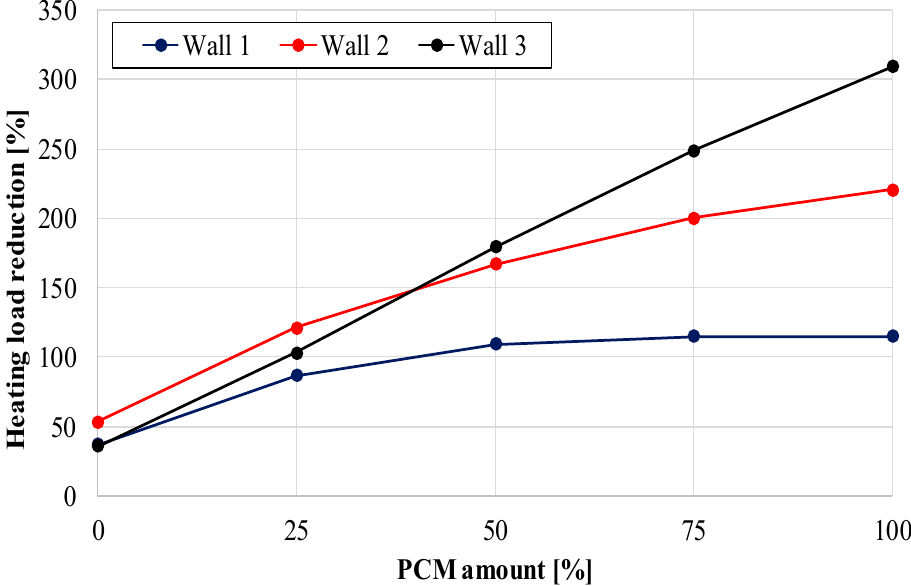
Figure 7. Heating load reduction in case of different amount of PCM.